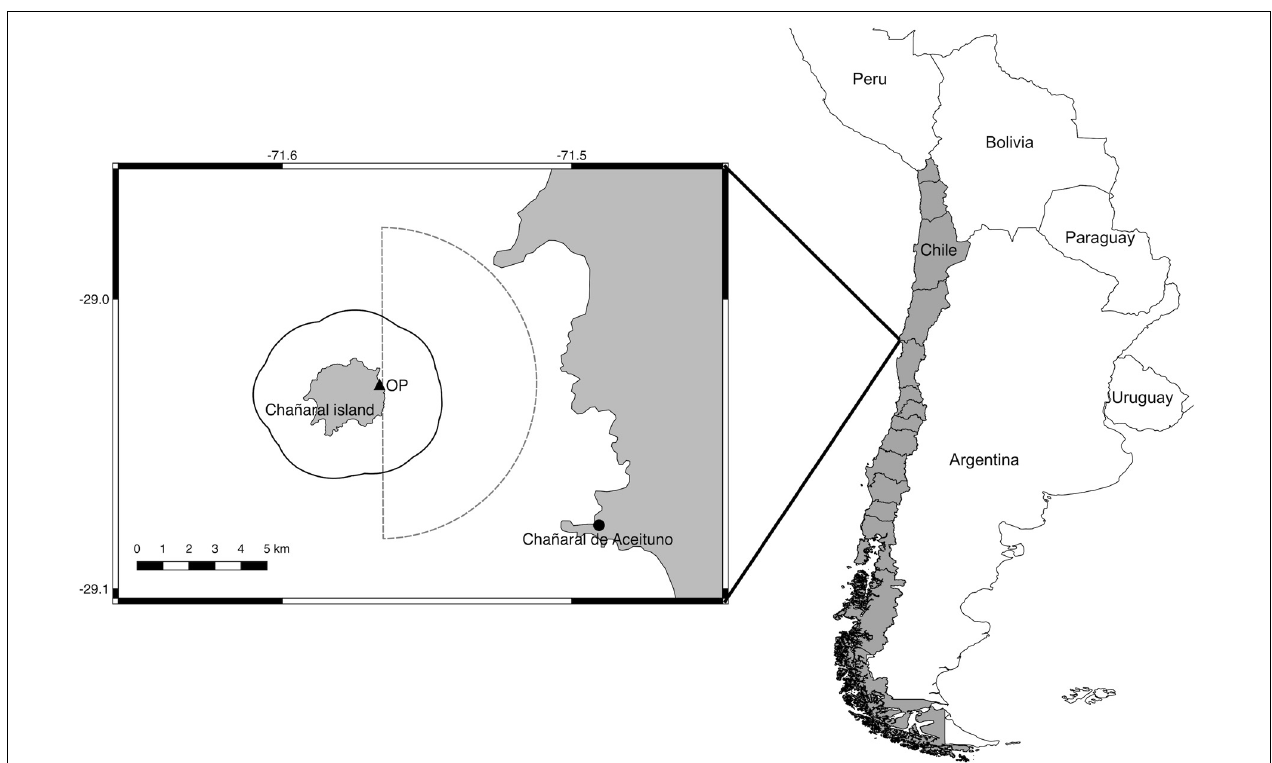
FIGURE 1 | Location of the study area. The black triangle indicates the land-based observation point (OP) and the black circle is the location of the caleta Chañaral de Aceituno. The black line indicates the limit of the Isla Chañaral Marine Reserve and the dashed line indicates the area of